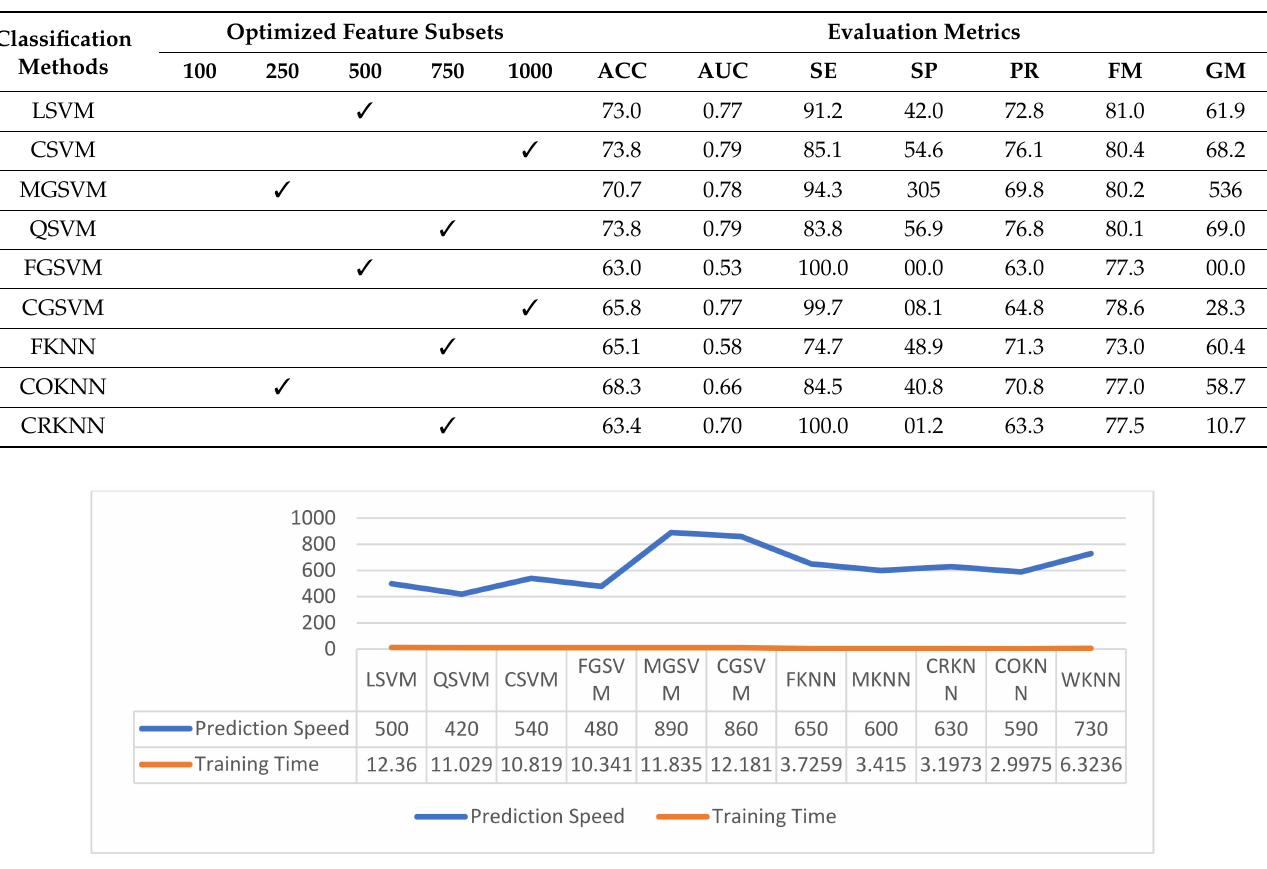
Figure 7. Proposed model training time (s) and prediction speed (obs/s) on back views of MIT dataset utilizing 1000- feature